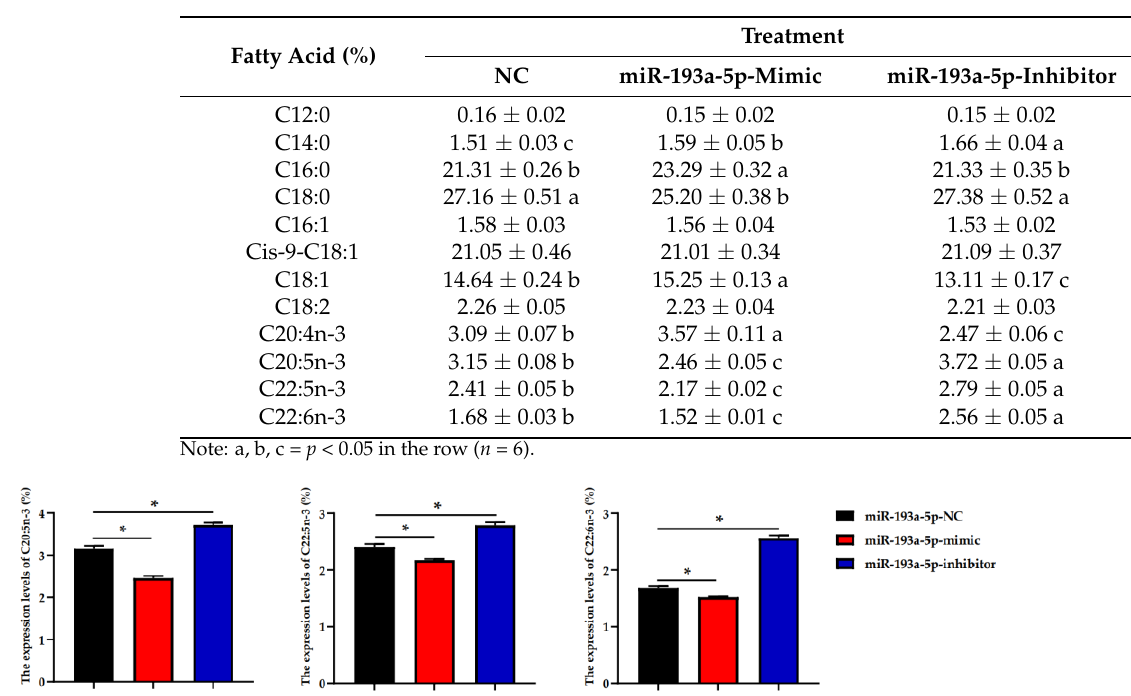
Table 1. Effects of miR-193a-5p mimic and inhibitor on intracellular fatty acid composition in BMECs.